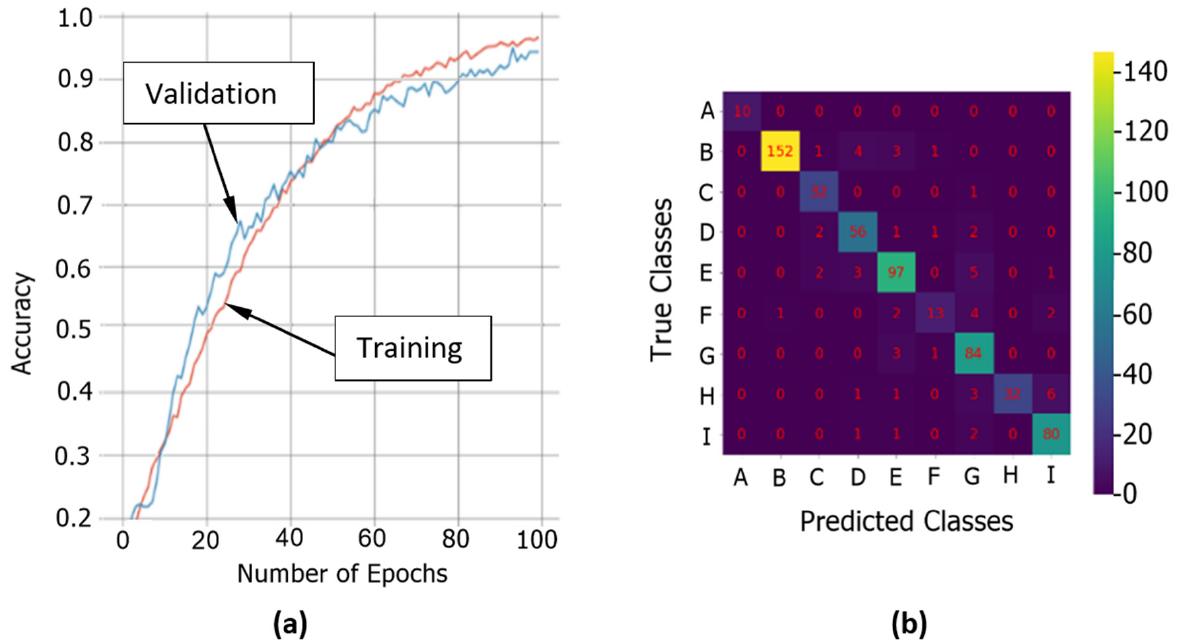
Figure 10. Graphics for MobileNetV2 architecture. ( a ) Training and validation accuracy ( b ) Confusion matrix for Test set. Apple variety legend: (A) Blanquina, (B) Carrió, (C) Florina, (D) Fuentes, (E) Prieta, (F) Raxao, (G) Reineta Encarnada, (H) Reineta Pinta, (I) Reineta Roja del Canadá.